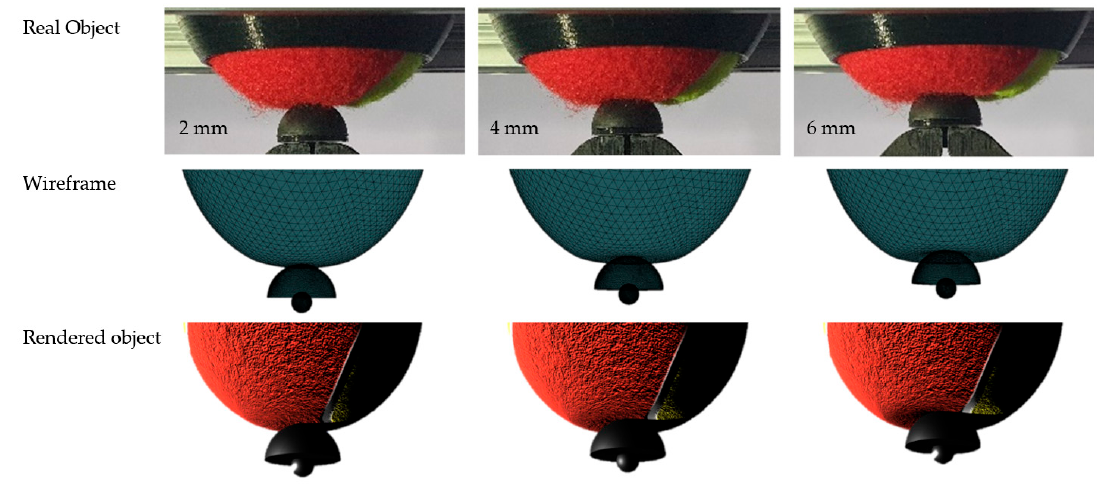
Figure 11. Deformation of the tennis-ball: Real versus rendered.